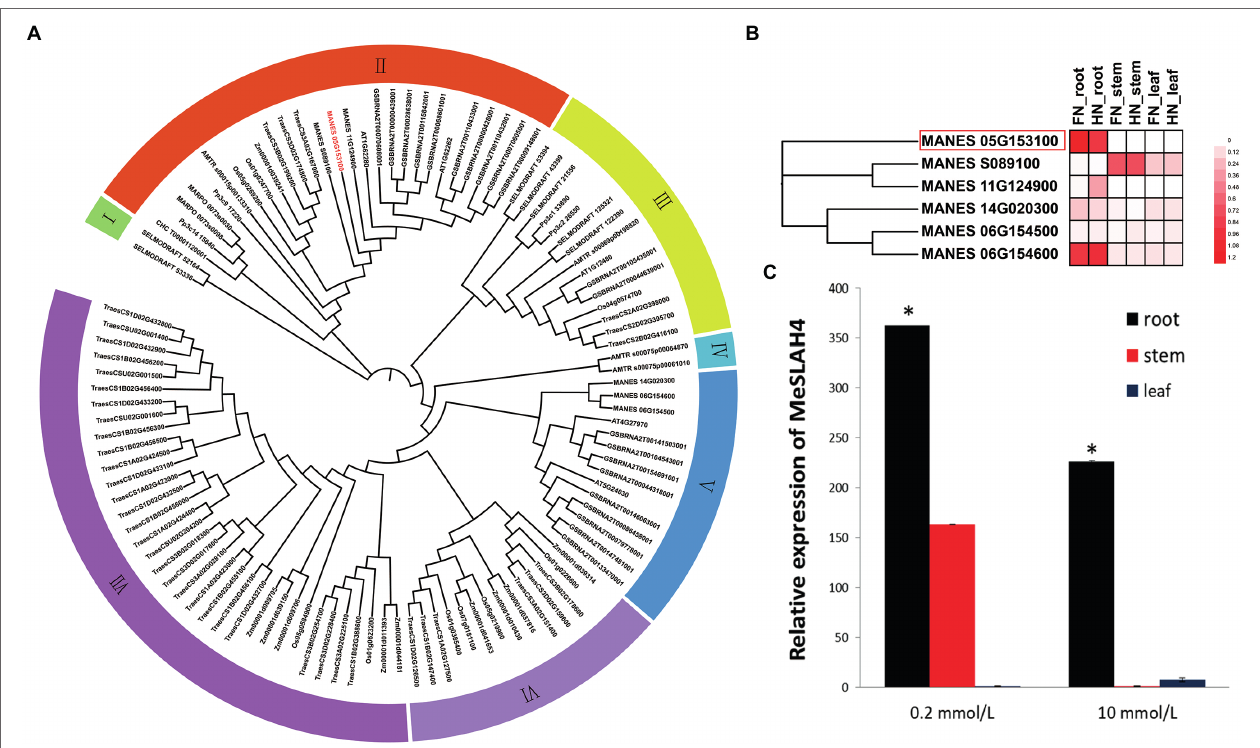
FIGURE 1 | Phylogenetic relationship and expression analysis of SLAH genes. (A) Phylogenetic tree of SLAH proteins constructed using ML method with 1,000 bootstrap replications in different species. The prefixes CHC, Pp3c, MARPO, AMTR, Os, Zm, Traes, MANES, AT, GSBRNA, and SELMODRAFT represent Chondrus crispus , Physcornitrella patens , Marchantia polymorpha , Amborella trichopoda , Oryza sativa , Zea mays , Triticum aestivum , Manihot esculenta , Arabidopsis thaliana , Brassica napus , and Selaginella moellendorffii . (B) Expression profiles of SLAH genes in the root, stem, and leaf of cassava under different nitrogen conditions. FN (0 mmol/l of nitrate nitrogen), and HN (10 mmol/l of nitrate nitrogen). (C) Relative expression of the MeSLAH4 gene in cassava. The relative expression levels were obtained by normalization with the MeActin gene. The error bars indicate standard deviations, and the data are shown as mean values ± SD, while * represents significant differences at p < 0.05 on one-way ANOVA